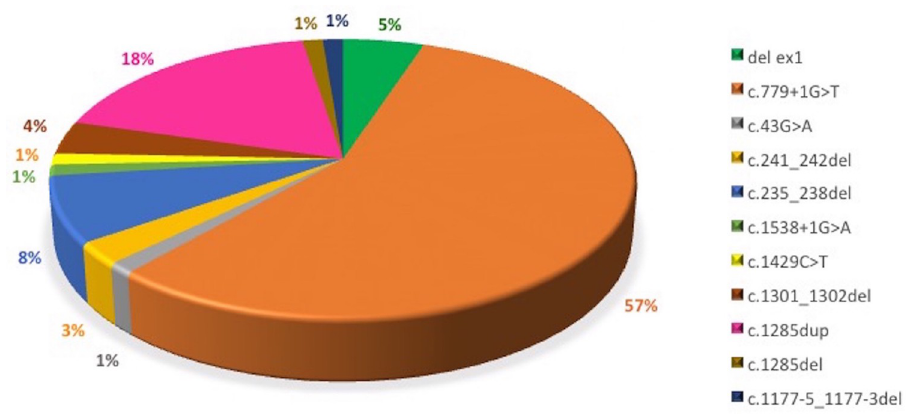
Fig 2. Proportions of the different variant detected in our cohort.